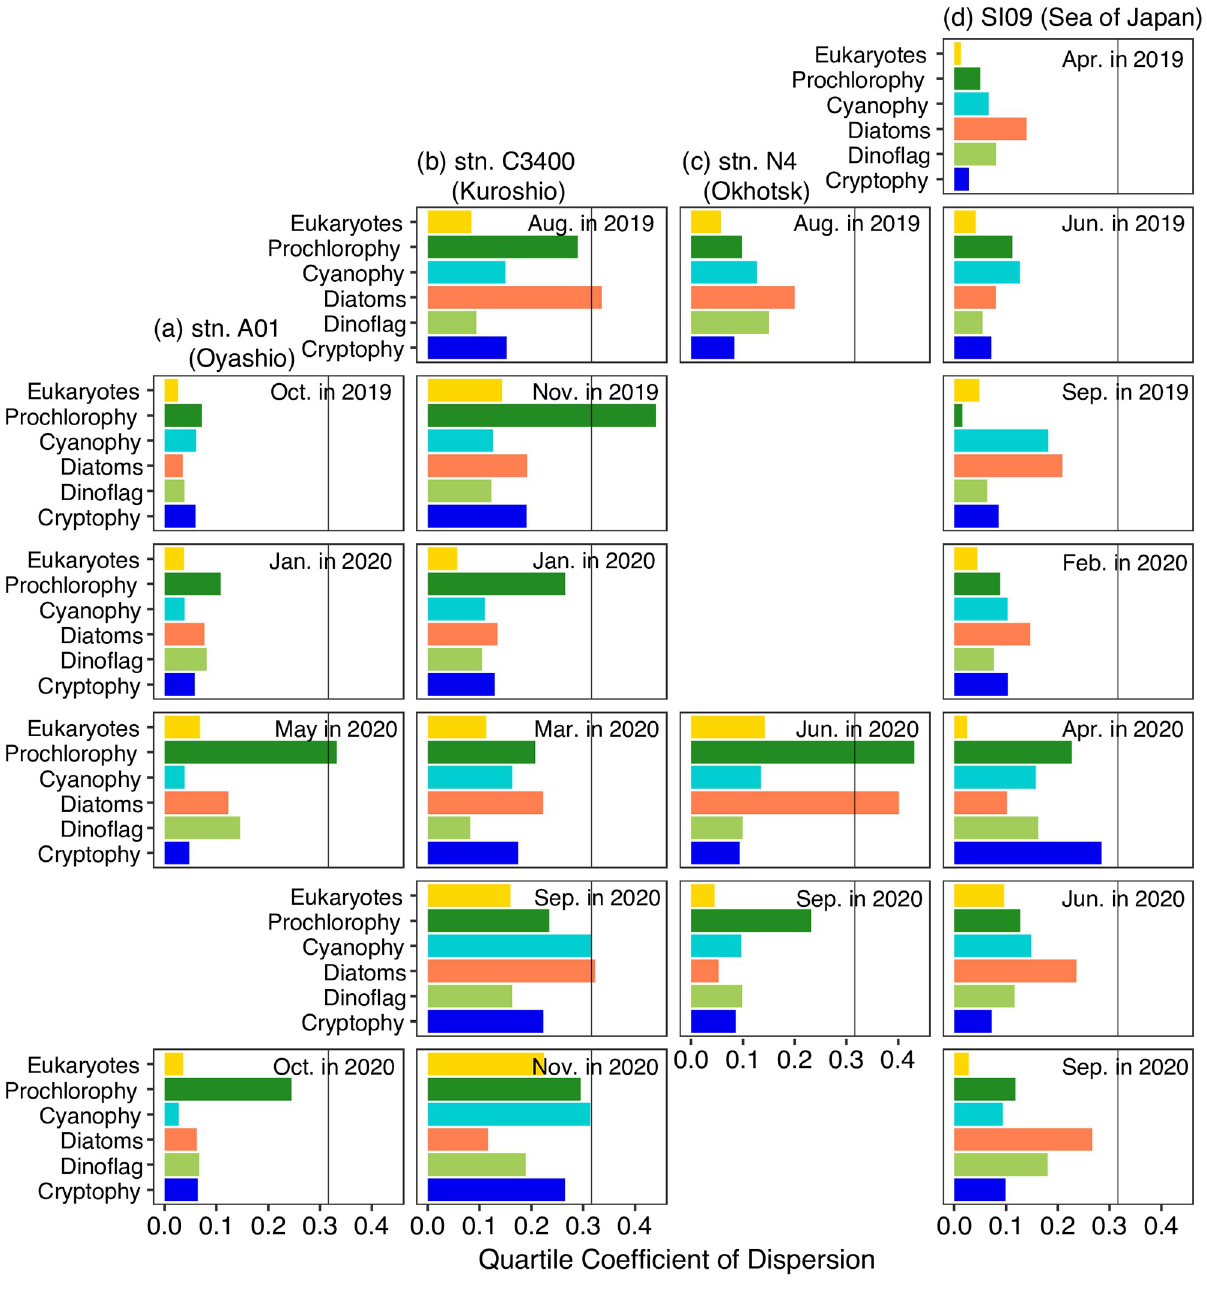
Fig 8. Vertical heterogeneity indices of phytoplankton assemblages based on quartile coefficient of dispersion (QcoD). The QcoD values of phytoplankton chemotaxnomy (a) stn. A01 in the Oyashio, (b) stn. C3400 in the Kuroshio, (c) stn. N4 in the Okhotsk Sea, and (d) stn. SI09 in the Sea of Japan (JS). The solid black vertical line represents the threshold of high heterogeneity (mean ± 2 sd of QcoD) of the vertical profiles. of 2020 (Fig 7c). On the other hand, diatoms contribution is high in the � 175 m at stn. C3400 in September of 2020 (Fig 7b). The proportion of prochlorophytes at stn. A01 in May of 2020 was low (median:7.3%), and varied unstably at this station (Fig 7a). The water-column integrated TChla based biomass of every phytoplankton group at every station and depth indicated that the eukaryote was dominant in the water column at all the